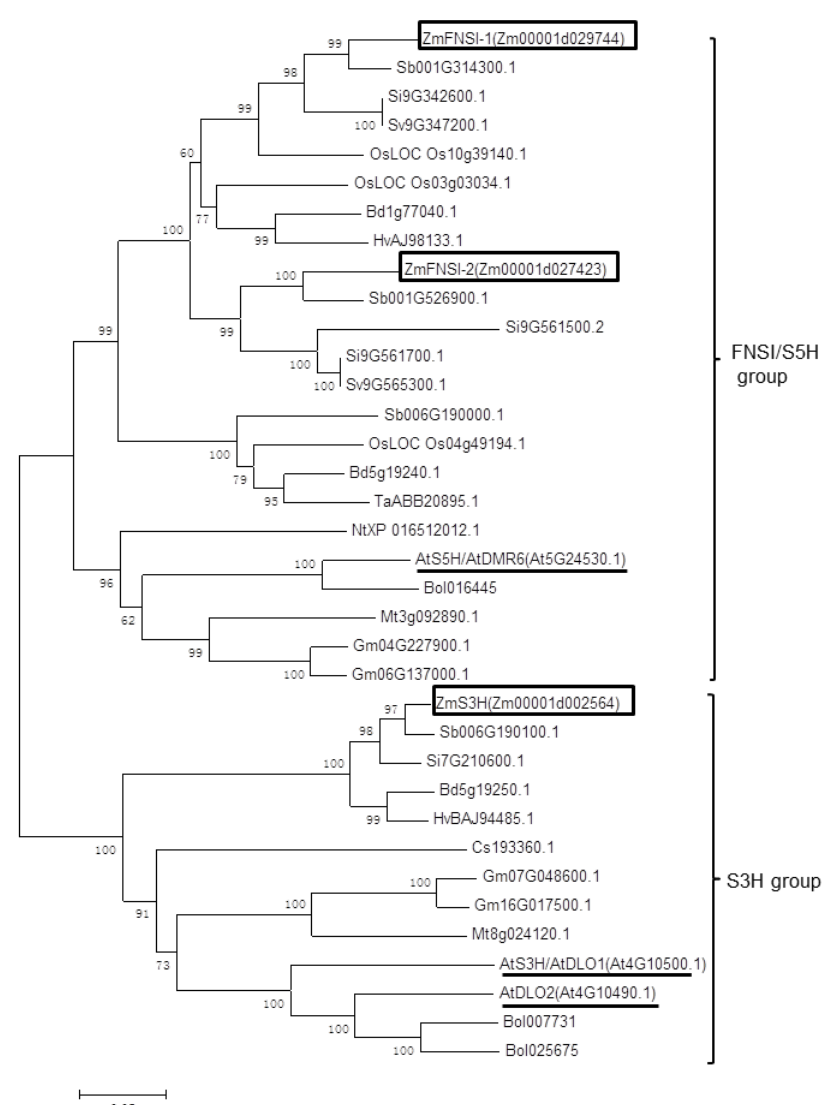
Figure 2. Phylogenetic analysis of FNSI/S5H and S3H proteins from different plant species. The protein sequences were aligned using Clustal X v2.1 and the phylogenetic tree was constructed using MEGA 6.0 software. At: Arabidopsis thaliana ; Bd: Brachypodium distachyon ; Bol: Brassica oleracea capitata ; Cs: Cucumis sativus ; Dc: Daucus carota ; Gm: Glycine max ; Hv: Hordeum vulgare ; Mt: Medicago truncatula ; Nt: Nicotiana tabacum ; Os: Oryza sativa ; Sb: Sorghum bicolor ; Si: Setaria italica ; Sv: Setaria viridis ; Ta: Triticum aestivum ; Tc: Theobroma cacao ; Zm: Zea mays. The boxes and the underlines indicated the proteins from maize and Arabidopsis , respectively.